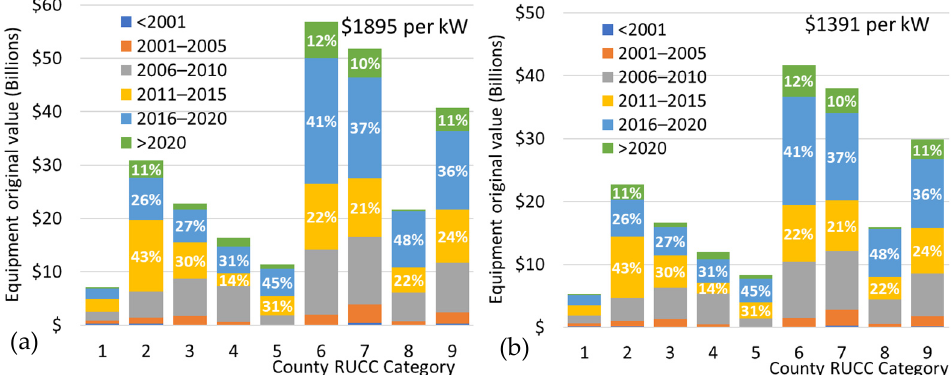
Figure 7. Wind turbine equipment original value at different values per NPC ( a ) USD1895 per kW ( b ) USD1391 per kW.